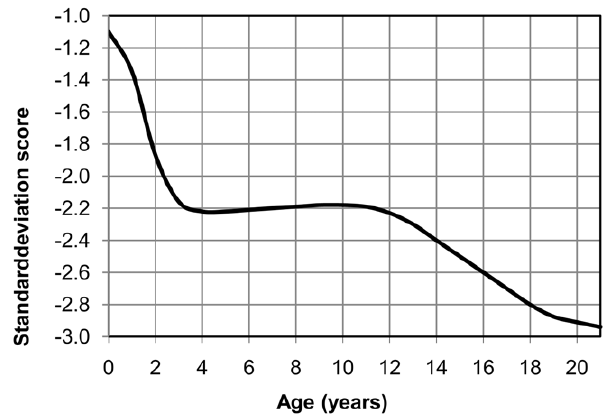
Figure 1. Mean height (SDS) of the Dutch children with Down syndrome compared to the general population. Comparison is made to the mean height of the national Dutch growth study (2009), calculated in standard deviation score